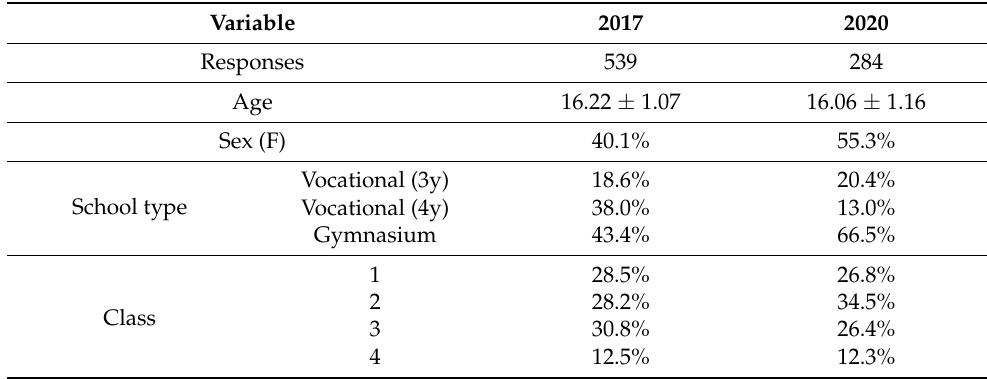
Table 1. Sociodemographic